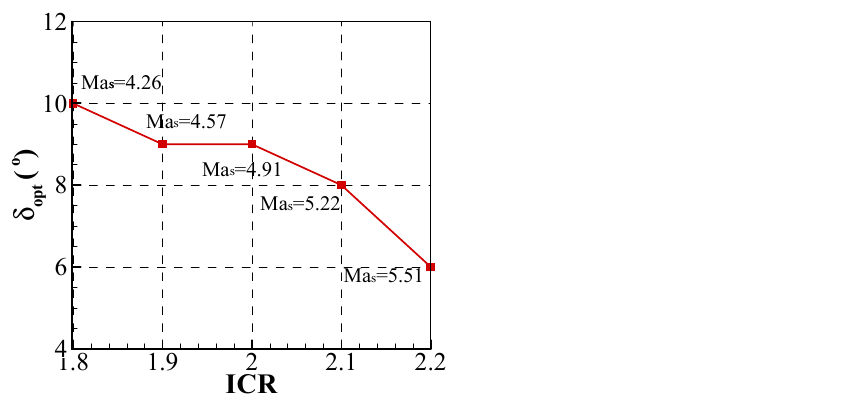
Figure 15. Distribution of δ opt and corresponding Ma s for the inlets with different ICRs.